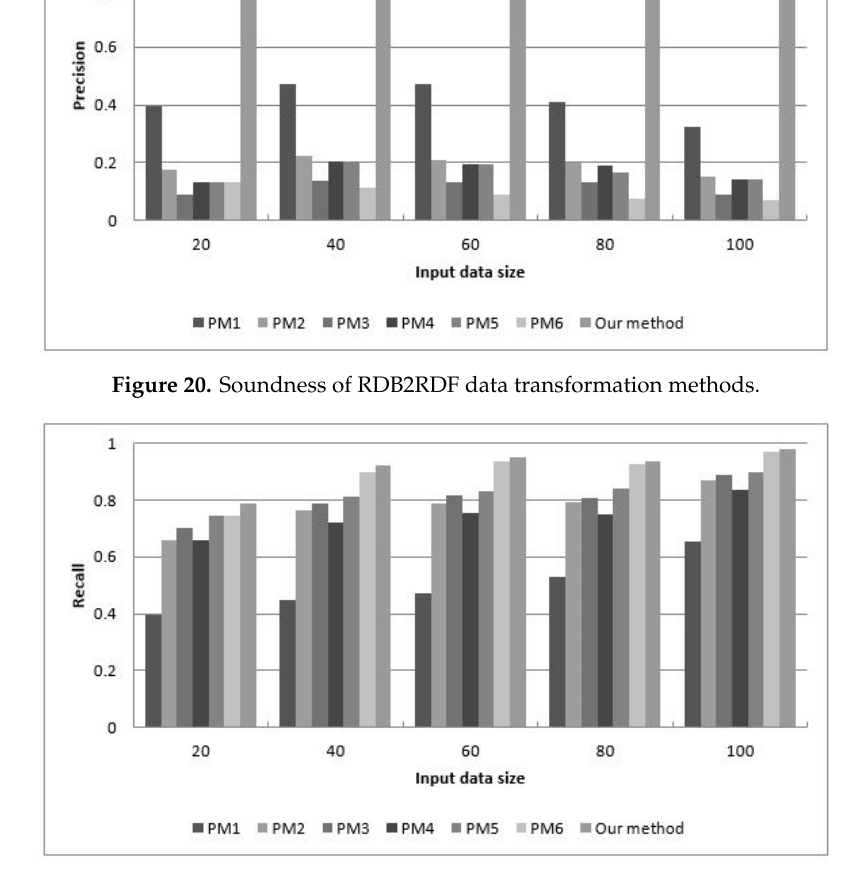
Figure 21. Completeness of RDB2RDF data transformation methods.